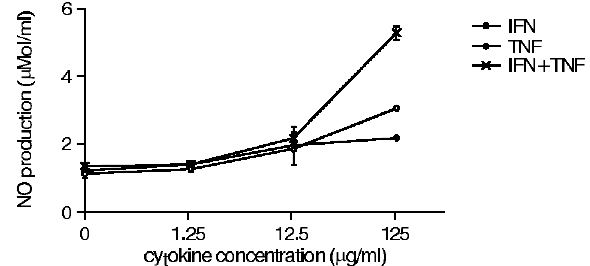
FIG. 6. Cytotoxic effect of cytokines. Groups of five mice were sacrificed and their peritoneal macrophages were collected. Macrophages were treated with different concentrations of interferon- g (IFN- g ), tumour necrosis factor (TNF) or IFN- g + TNF for 24h and infected with 1.5 ´ 10 6 colony-forming units of viable BCG bacilli. Nitric oxide (NO) levels were assayed by the Griess colorimetric reactions. Each point represents the values of samples from five experiments ± standard deviation in different groups of five